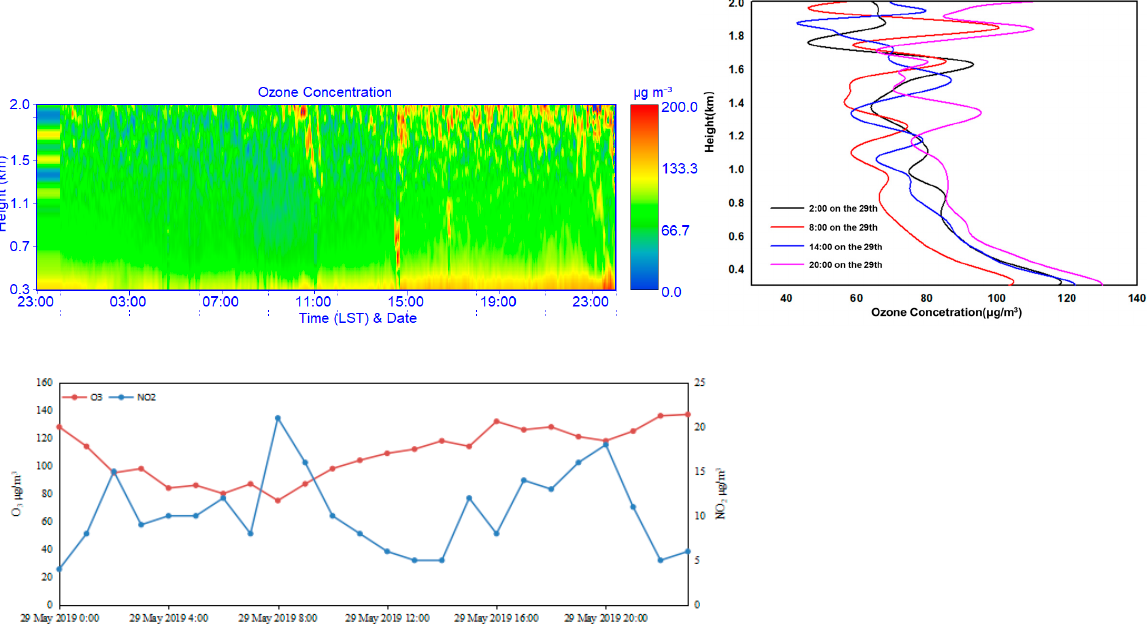
Figure 8. Ozone vertical profile of ozone and the titration effect after local ozone formation. ( Left ) the changing trend of ozone concentration distribution and variations of ozone and NO 2 ; ( Right ) ozone concentration vs. height.